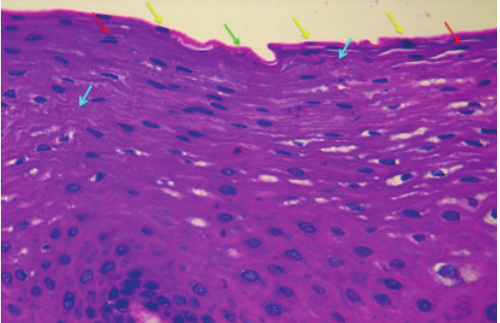
Figure 5: Conventional histology image under light microscopy showing the uppermost epithelial layers. Green arrow: non-kerati- nized area pinpointing abscence of nuclei. Yellow arrows: paraker- atinized areas with presence of nuclei in the uppermost epithelial layer. Red arrows: flat nuclei in upper epithelial layers. Blue arrows: largefilament content ofcytoplasm giving appearance of microfolds.